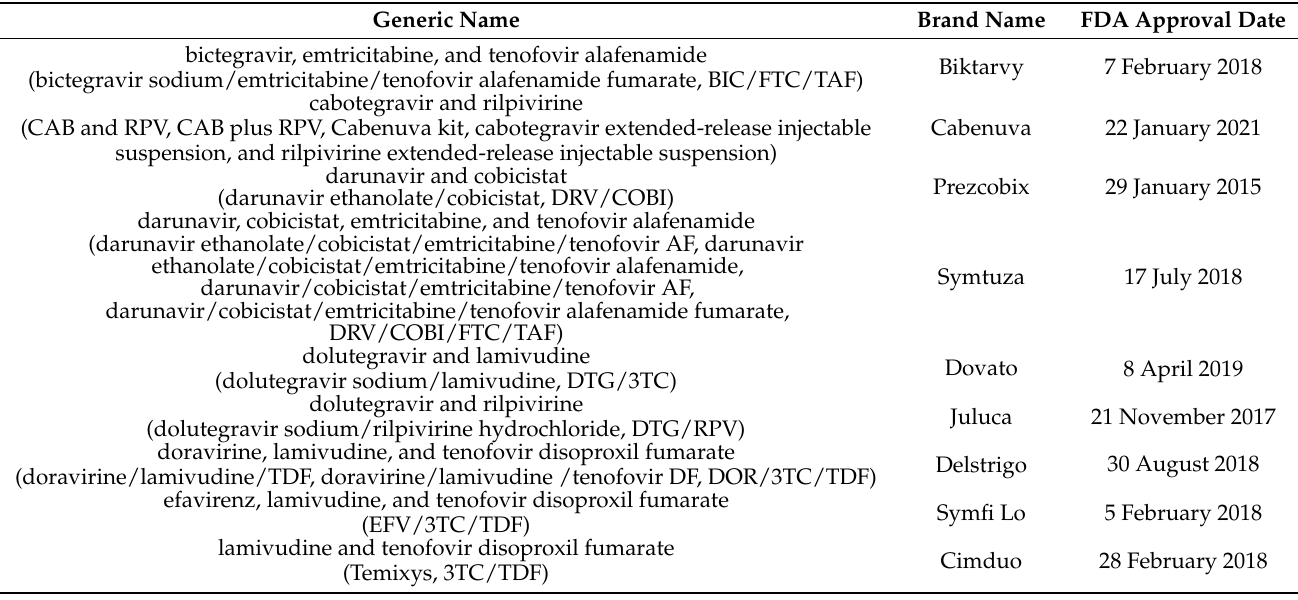
Table 5. FDA approved combination HIV medicines 2016–2021. Containing two or more HIV medicines from one or more drug